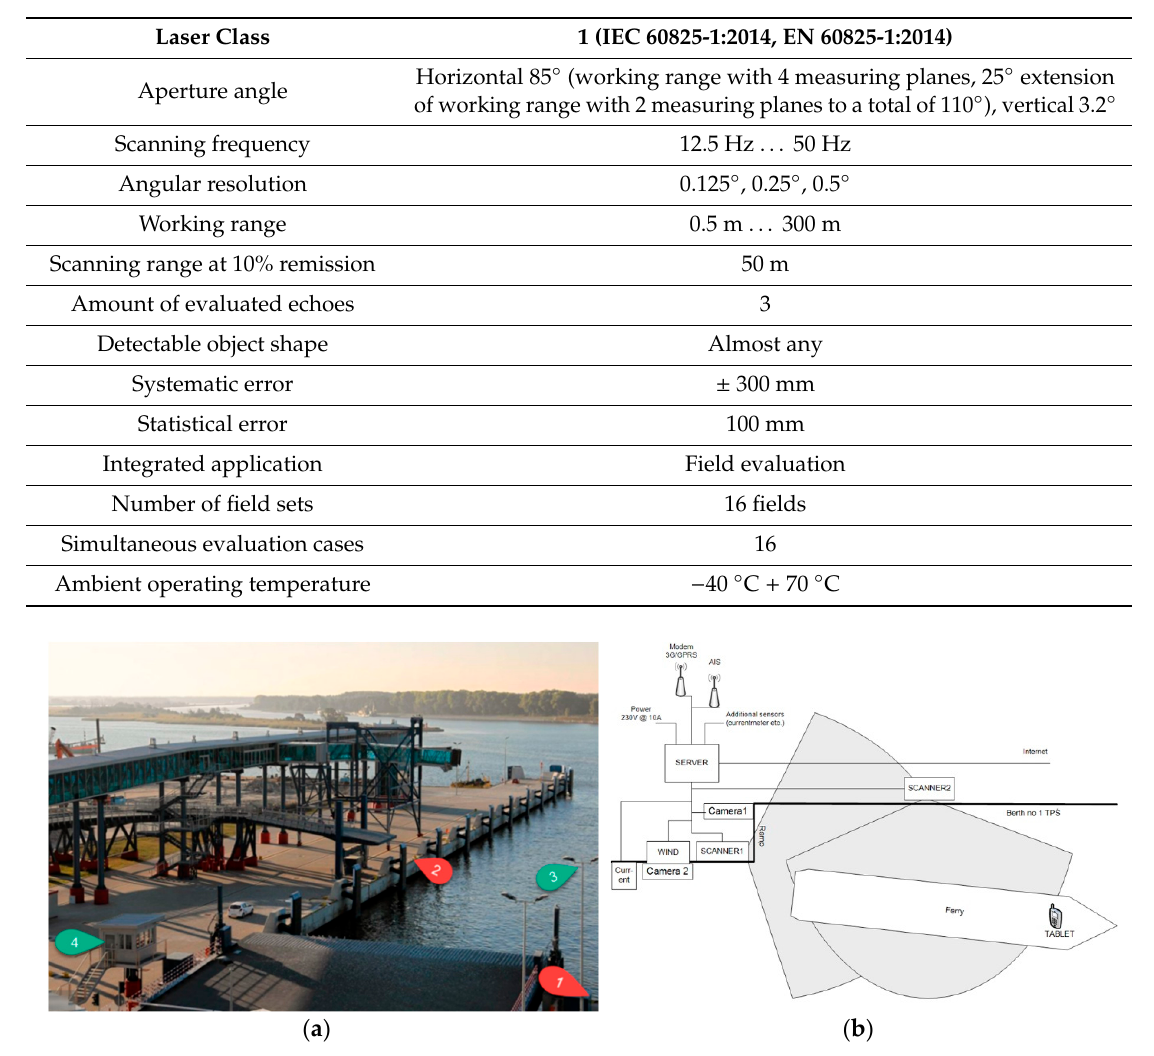
Table 8. LiDARs specification (outdoor use).